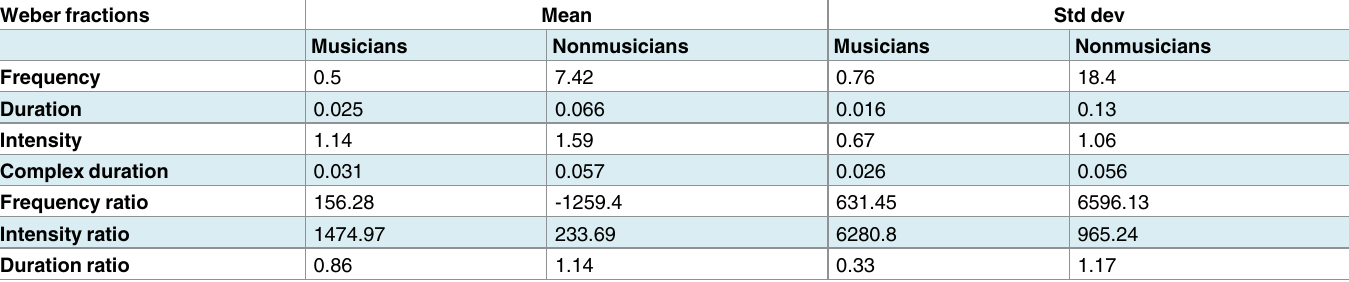
Table 2. Mean and standard deviation of Weber fractions for musicians and nonmusicians for each perceptual variable of interest.